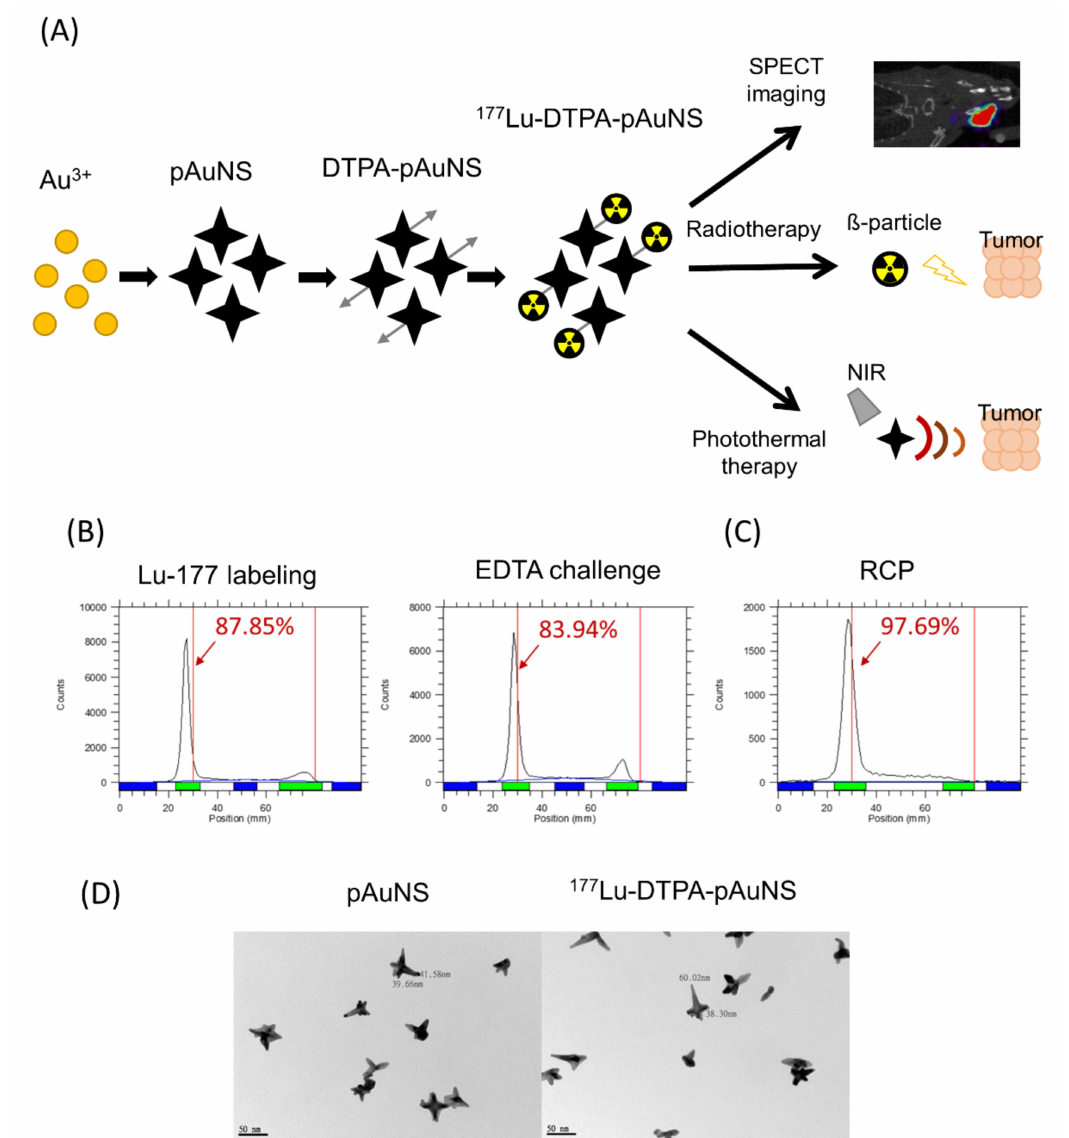
Figure 1. Construction and Radiolabeling of 177 Lu labeled PEGylated gold nanostars ( 177 Lu-DTPA-pAuNS). ( A ) Flow